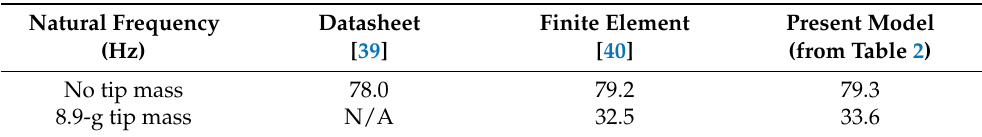
Table 3. The first natural frequency comparison between the present model, manufacturer’s datasheet, and the finite